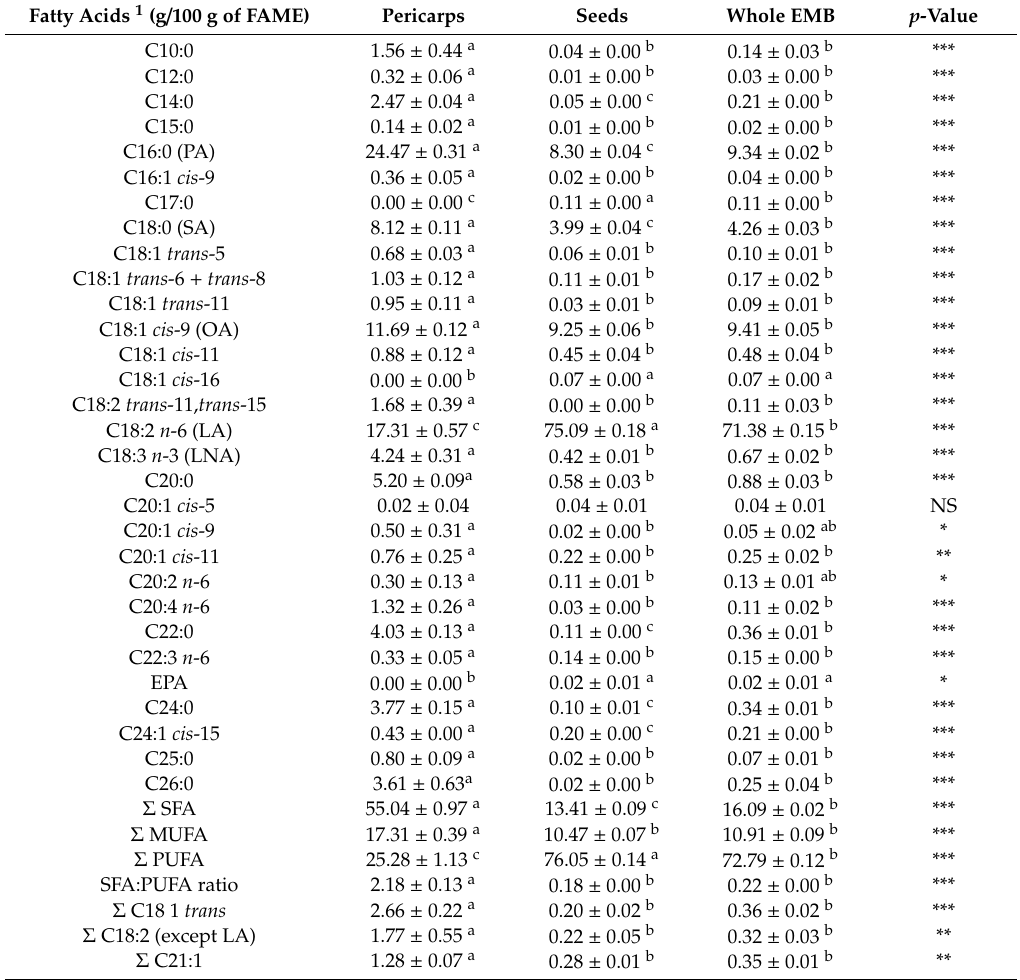
Table 2. Fatty acid profile (mean of FAME ± SD) of seeds, pericarps and whole exhausted barriers of myrtle resulted from liquor